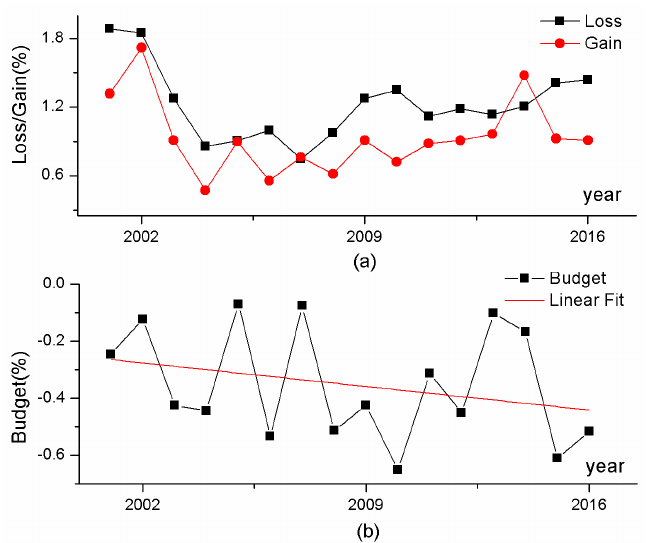
Figure 5. The dynamics of inland water over the years (the figure shows water dynamics per year across the study area), Figure ( a ) shows percentage of loss and gain area over the years and Figure ( b ) shows percentage of budget area over the years.